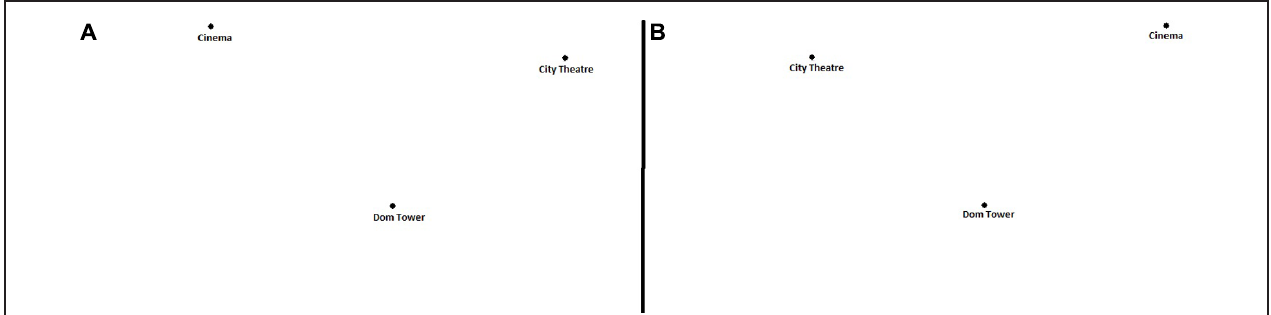
FIGURE 1 | One correct (A) and one mirrored, incorrect (B) place triad from the Relative Position judgment task for buildings found in the city of Utrecht.